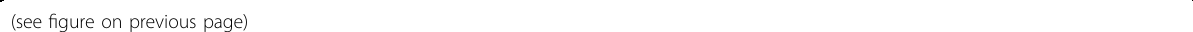
Fig. 2 3 ′ UTR shortening of NLRP3 ampli fi es in fl ammation, fi brogenesis, ROS production, and apoptosis in renal tubular epithelial cells. A Western blot was performed to determine the protein levels of Flag, caspase1, IL-1 β , and IL-18 in HK2 and HKC cells transfected with empty vector, short 3 ′ UTR NLRP3 or long 3 ′ UTR NLRP3 respectively. B Quantitative analysis of protein levels of caspase1, IL-1 β and IL-18 in HK2 and HKC cells transfected with empty vector, short 3 ′ UTR NLRP3 or long 3 ′ UTR NLRP3 . C Western blot was performed to determine the protein levels of Flag, phospho-SMAD3, E-cadherin, and N-cadherin in HK2 and HKC cells transfected with empty vector, short 3 ′ UTR NLRP3 or long 3 ′ UTR NLRP3 respectively. D Quantitative analysis of protein levels of phospho-SMAD3, E-cadherin and N-cadherin in HK2 and HKC cells transfected with empty vector, short 3 ′ UTR NLRP3 or long 3 ′ UTR NLRP3 . E Western blot was performed to determine the protein levels of Flag, collagen I, fi bronectin, and α - SMA in HK2 and HKC cells transfected with empty vector, short 3 ′ UTR NLRP3 or long 3 ′ UTR NLRP3 respectively. F Quantitative analysis of protein levels of collagen I, fi bronectin, and α -SMA in HK2 and HKC cells transfected with empty vector, short 3 ′ UTR NLRP3 or long 3 ′ UTR NLRP3 . G Representative images and quantitative analysis of DHE and DCFH-DA staining in HK2 cells transfected with empty vector, short 3 ′ UTR NLRP3 or long 3 ′ UTR NLRP3 . H Representative images and quantitative analysis of TUNEL staining in HK2 cells transfected with empty vector, short 3 ′ UTR NLRP3 or long 3 ′ UTR NLRP3 . * P < 0.05; ** P < 0.01; *** P < 0.001; All data represent the mean ± SEM obtained from three independent experiments. Student ’ s t